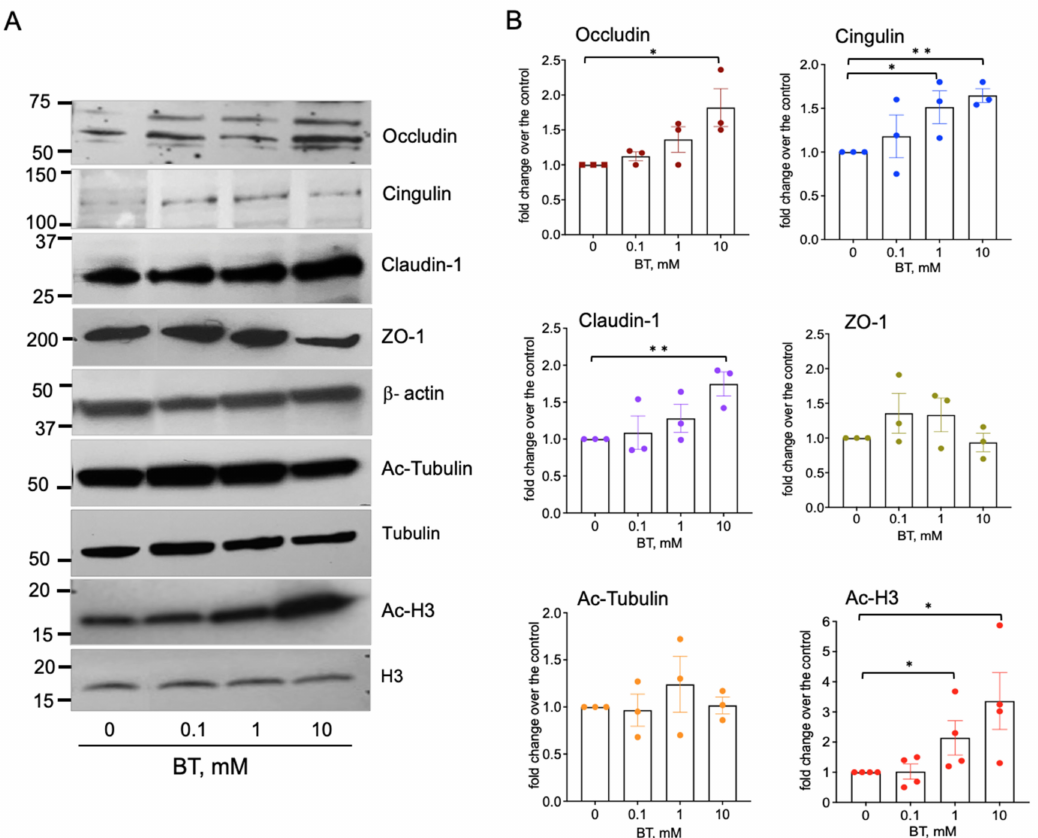
Figure 5. Butyrate upregulates the expression of tight junctional proteins in rat lung microvascular endothelial cells. ( A ): Western blot analysis of tight junctional proteins, Ac-tubulin, and Ac-H3 in RMVEC. Growth-arrested cells (48 h, DMEM without serum) remained untreated or stimulated with butyrate (0.1, 1, and 10 mM) for 24 h. Total cell lysates (20–30 µ g) were subjected to Western blot analysis ( B ): Densitometric analysis of Western blot data show the relative intensity of protein expression in butyrate-stimulated cell versus without treatment; data represent a mean +/ − SED from three to four independent experiments; * p < 0.05; ** p < 0.01.